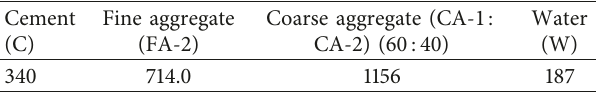
Table 3: Detail of concrete mix